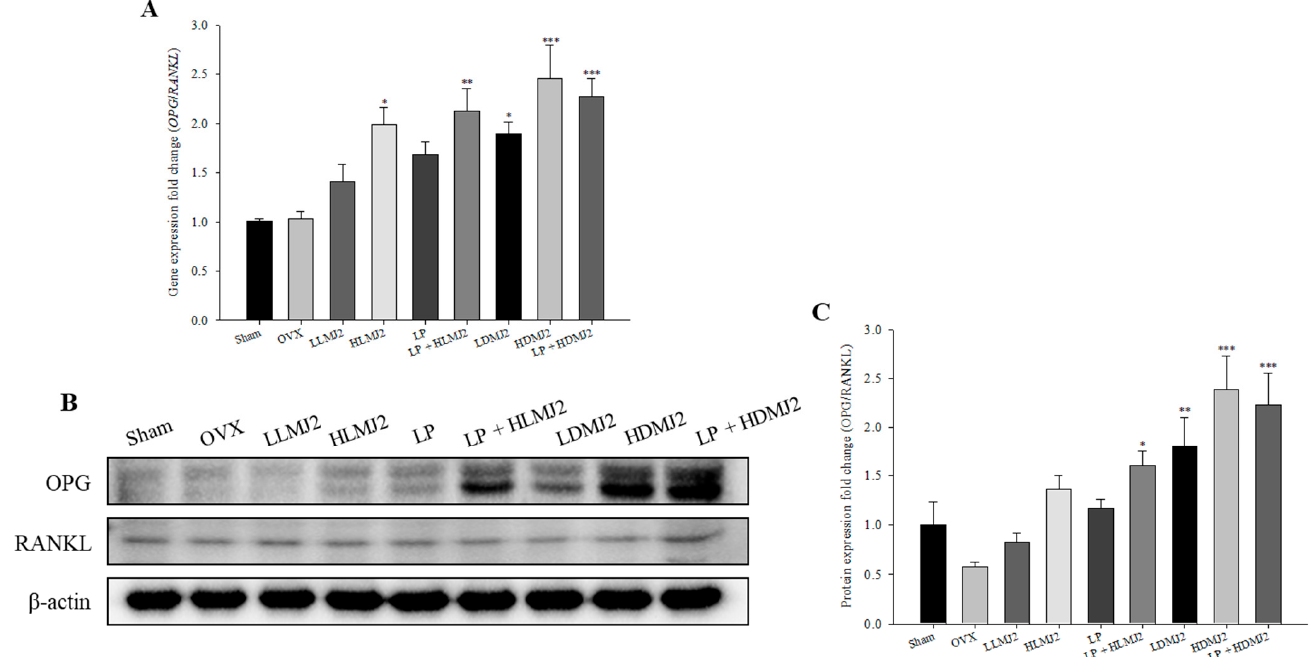
Figure 8. Effect of MJ2 and L. plantarum on the OPG/RANKL ratio and expression of osteoblast differentiation-related genes and proteins. The gene expression levels of OPG/RANKL ( A ) and expression levels of the proteins were measured by Western blotting ( B ) and quantified ( C ). Each value indicates the mean ± SEM of three independent experiments performed in triplicate. * p < 0.05, ** p < 0.01, and *** p < 0.001 compared with the OVX group.